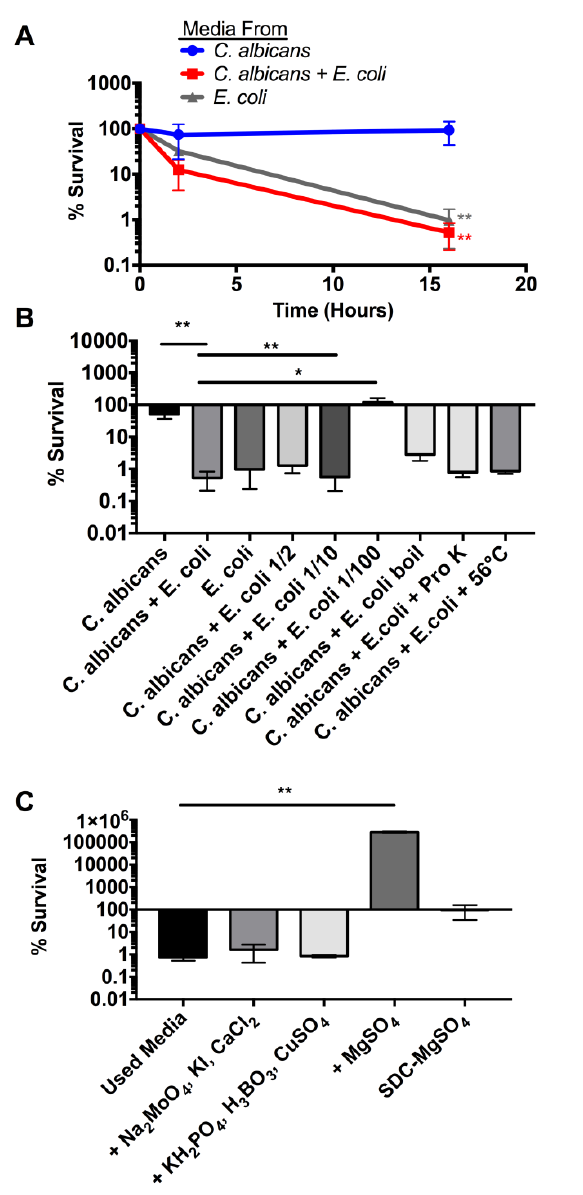
FIGURE 2 : E. coli produces a soluble fungicidal molecule. (A) Percent survival of C. albicans cultured in the indicated conditioned media collected after 6 hours of co-culture . Statistical significance was calcu- lated using an unpaired two-tailed t-test in which the E. coli and the C. albicans + E. coli medias were compared to the C. albicans media control. (B) Percent survival of C. albicans cultured in the indicated conditioned media for 16 hours. Statistical significance was calculated using a one-way ANOVA in Prism 7.0. P-values were subsequently corrected for multiple comparisons using the Bonferroni method. All conditions were compared to the C. albicans media control. (C) Per- cent survival of C. albicans cultured in E. coli + C. albicans conditioned media for 16 hours. Compounds were added at the concentrations consistent with standard YNB [Boric acid (0.5 mg/L), Copper (II) sulfate pentahydrate (0.04 mg/L) Sodium molybdate (0.2 mg/L), Potassium iodide (0.1 mg/L), Calcium chloride dihydrate (100 mg/L), Potassium phosphate monobasic anhydrous (1000 mg/L) and Magnesium sulfate anhydrous (500 mg/L)]. Statistical significance was calculated using a one-way ANOVA in Prism 7.0 to compare all conditions to the used media control. P-values were subsequently corrected for multiple comparisons using the Bonferroni method. Statistical significance is shown (*p > 0.05; **p > 0.01 ***p >